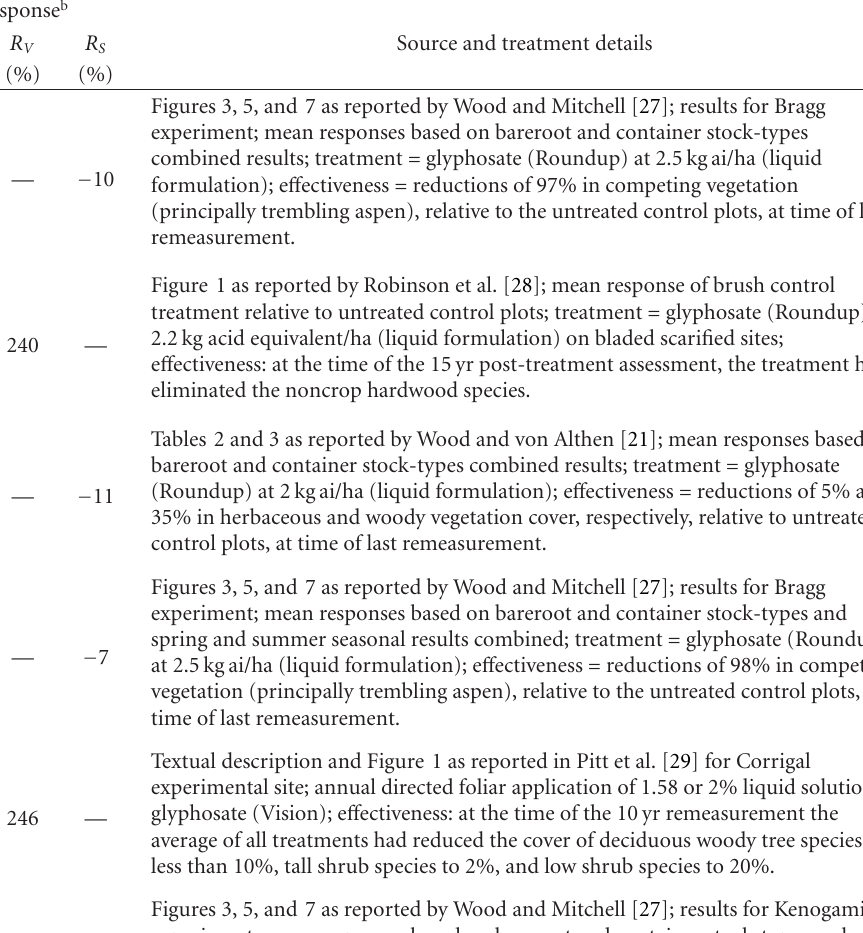
Figure 1 as reported by Robinson et al. [28]; mean response of brush control treatment relative to untreated control plots; treatment = glyphosate (Roundup) at 2.2 kg acid equivalent/ha (liquid formulation) on bladed scarified sites; e ff ectiveness: at the time of the 15yr post-treatment assessment, the treatment had eliminated the noncrop hardwood species. Tables 2 and 3 as reported by Wood and von Althen [21]; mean responses based on bareroot and container stock-types combined results; treatment = glyphosate (Roundup) at 2kg ai/ha (liquid formulation); e ff ectiveness = reductions of 5% and 35% in herbaceous and woody vegetation cover, respectively, relative to untreated control plots, at time of last remeasurement. Figures 3, 5, and 7 as reported by Wood and Mitchell [27]; results for Bragg experiment; mean responses based on bareroot and container stock-types and spring and summer seasonal results combined; treatment = glyphosate (Roundup) at 2.5kg ai/ha (liquid formulation); e ff ectiveness = reductions of 98% in competing vegetation (principally trembling aspen), relative to the untreated control plots, at time of last remeasurement. Textual description and Figure 1 as reported in Pitt et al. [29] for Corrigal experimental site; annual directed foliar application of 1.58 or 2% liquid solution of glyphosate (Vision); e ff ectiveness: at the time of the 10yr remeasurement the average of all treatments had reduced the cover of deciduous woody tree species to less than 10%, tall shrub species to 2%, and low shrub species to 20%. Figures 3, 5, and 7 as reported by Wood and Mitchell [27]; results for Kenogaming experiment; mean responses based on bareroot and container stock-types and spring and summer seasonal results combined; treatment = glyphosate (Roundup) at 2.14 kgai/ha (liquid formulation); e ff ectiveness = reductions of 76% in competing vegetation (principally trembling aspen), relative to the untreated control plots, at time of last remeasurement. Figures 3, 5, and 7 as reported by Wood and Mitchell [27]; results for Lampugh experiment; mean responses based on bareroot and container stock-types and spring and summer seasonal results combined; treatment = glyphosate (Roundup) at 2.14 kgai/ha (liquid formulation); e ff ectiveness = reductions of 94% in competing vegetation (principally trembling aspen), relative to the untreated control plots, at time of last remeasurement. Textual description and Figure 1 as reported in Pitt et al. [29] for Hele experimental site; treatment = glyphosate (Vision) at 1.7 kgai/ha (liquid formulation); e ff ectiveness: at the time of the 10yr remeasurement the average of all treatments had reduced the cover of deciduous woody tree species to less than 10%, tall shrub species to 2%, and low shrub species to 20%. Table 1 and Figure 2 as reported by Wagner et al. [25]; treatment = glyphosate (Vision) at 4 kgai/ha (liquid formulation); e ff ectiveness = reduction of 20% in herbaceous vegetation cover, relative to the untreated control plots, at the time of last remeasurement ( n ., nil competition from woody species). Table 1 and Figure 2 as reported by Wagner et al. [25]; treatment = glyphosate (Vision) at 4 kgai/ha (liquid formulation); e ff ectiveness = reduction of 21% in herbaceous vegetation cover, relative to the untreated control plots, at the time of last remeasurement ( n ., nil competition from woody